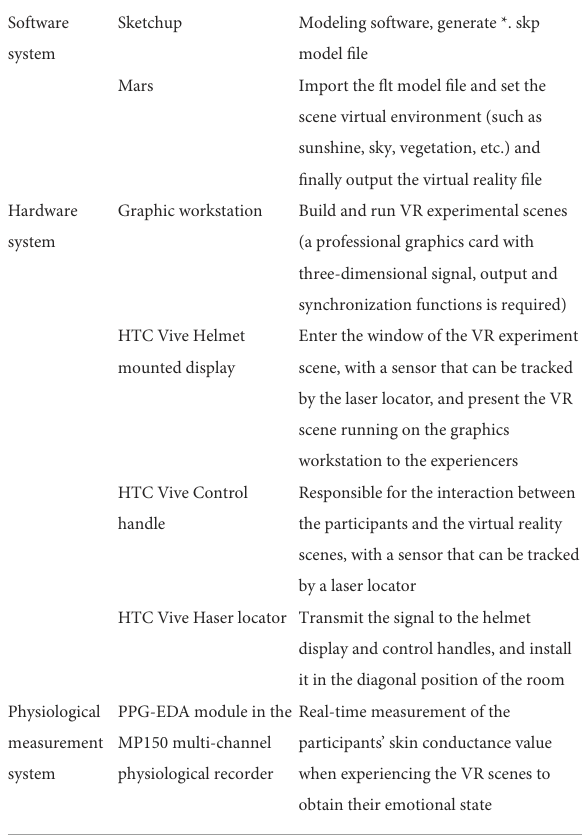
TABLE 3 Virtual reality experiment